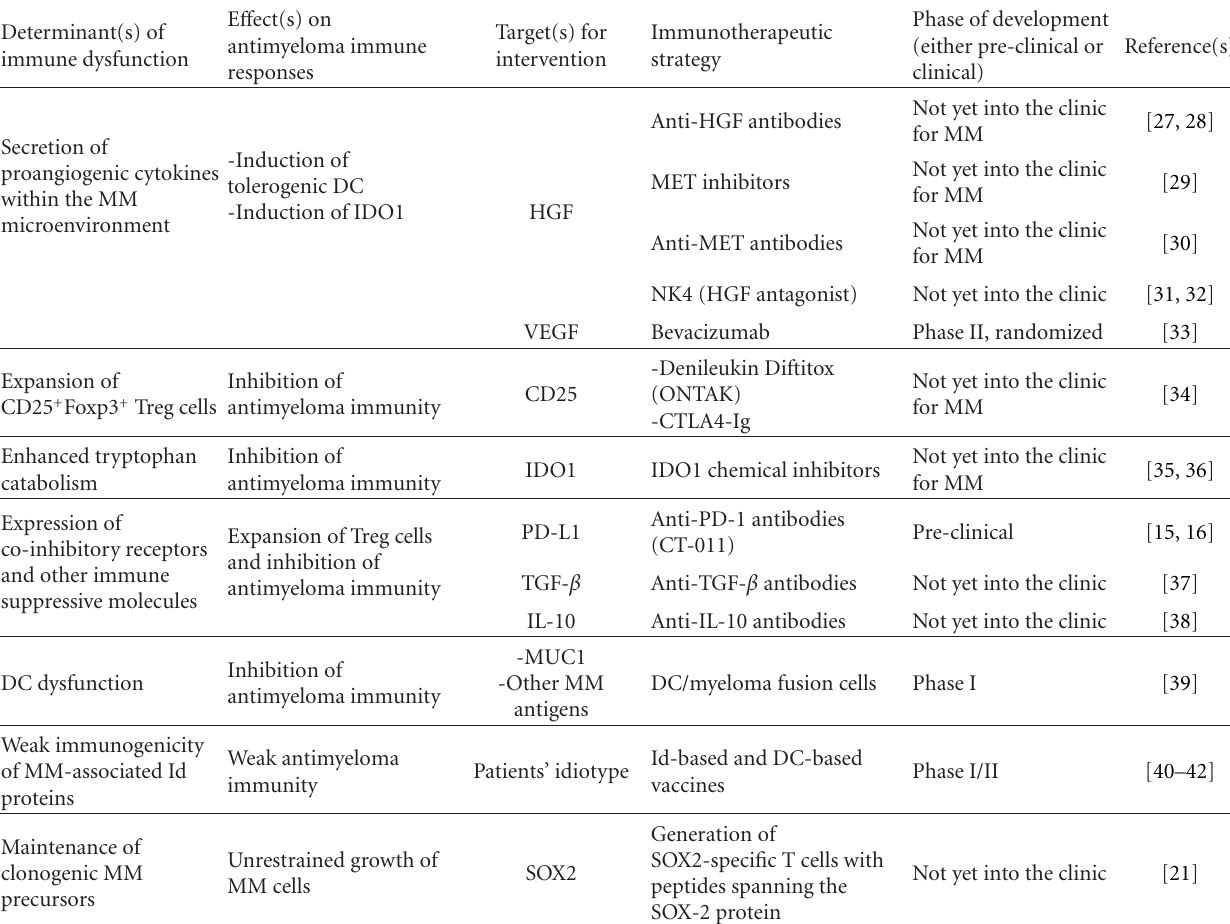
Table 1: Immune suppressive circuits and molecular targets for immunotherapeutic approaches in MM. The mechanisms of immune evasion mediated by MM cells and the currently available strategies to target them are